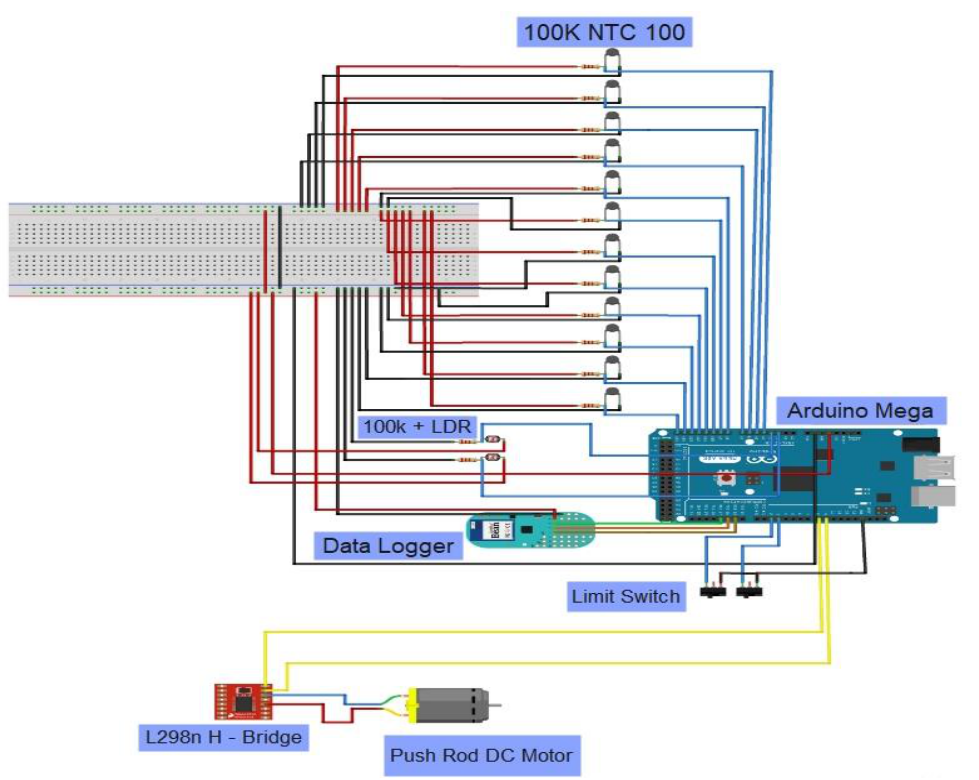
Figure 3. Temperature measurements sent to a data logger via an Arduino Mega.